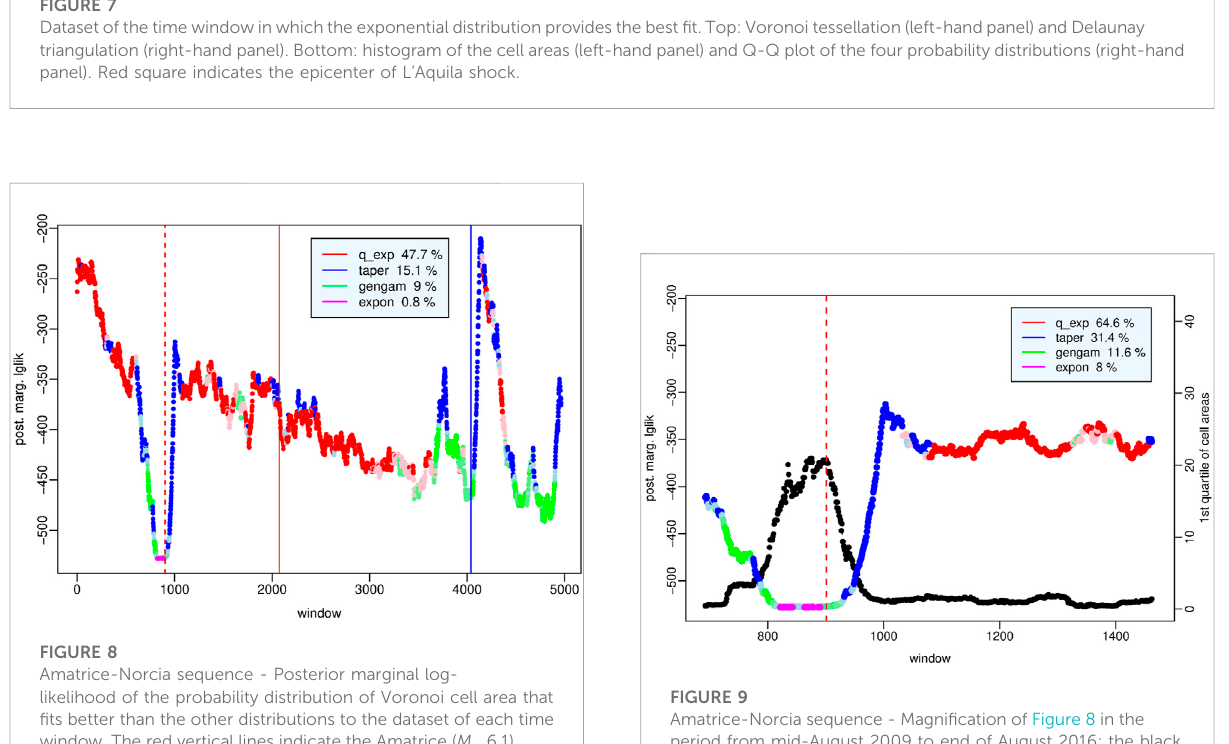
FIGURE 9 Amatrice-Norcia sequence - Magni fi cation of Figure 8 in the period from mid-August 2009 to end of August 2016; the black dots indicate the fi rst quartile of the set of cell areas in each time window. Red dashed vertical line indicates the Amatrice